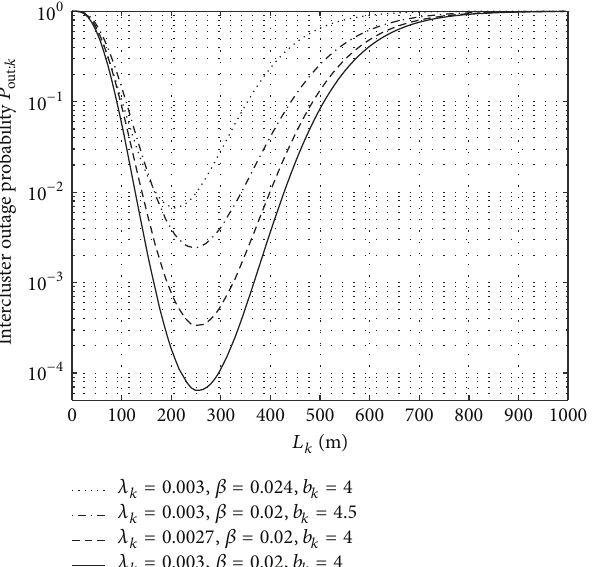
𝑃 𝐾(𝛽 = 0.02, 𝛽 󸀠 = 𝛽/4, 𝜆 = 0.003, and 𝑏 out versus 4)